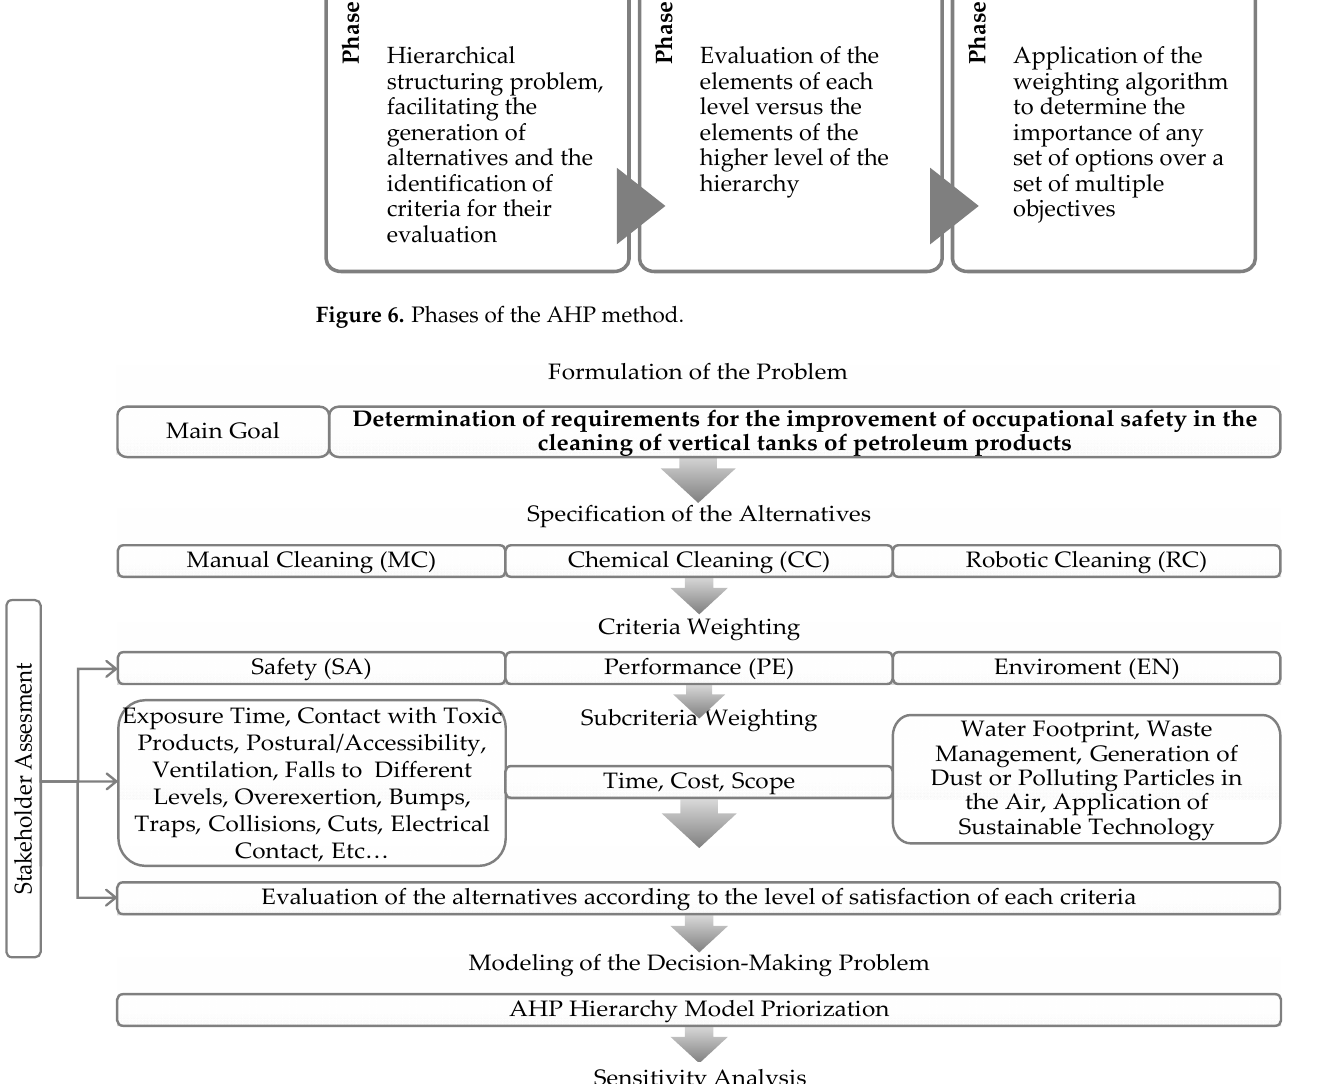
Figure 7. Decision ‐ making process. Figure 7. Decision-making Table 2. Identification of criteria and subcriteria.